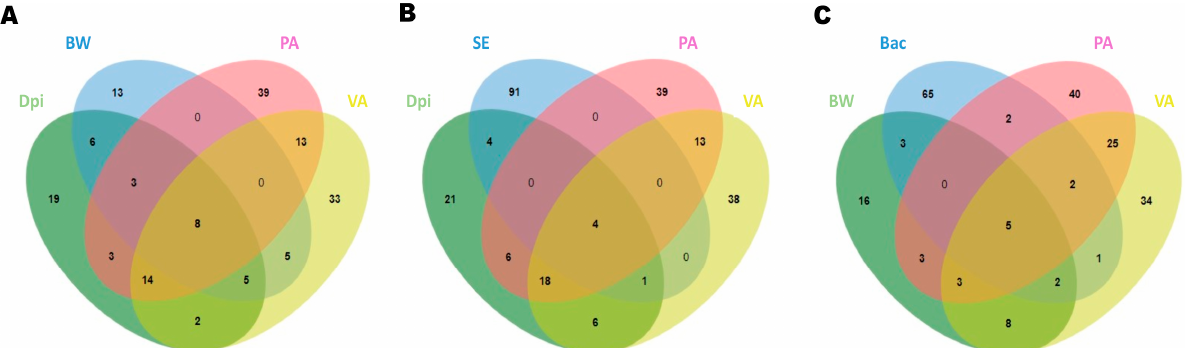
Figure 8. Overlap of driver gene contained in all the modules identified as highly correlated with the indicated trait. ( A ) Dpi (day post-infection) vs. BW (body weight post-infection) vs. PA (propionate cecal content) vs. VA (valerate cecal content). ( B ) Dpi (day post-infection) vs. SE (bacterial load from cecum) vs. PA (propionate cecal content) vs. VA (valerate cecal content). ( C ) BW (body weight post-infection) vs. Bac (Bacteroides cecal relative abundance) vs. PA (propionate cecal content) vs. VA (valerate cecal content).